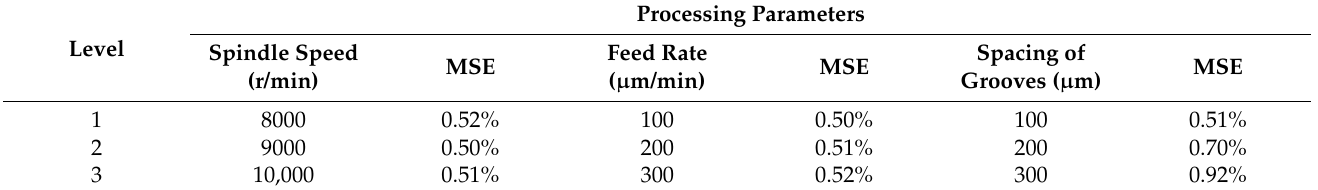
Table 2. MSE of the reference plane under different micromilling parameters.